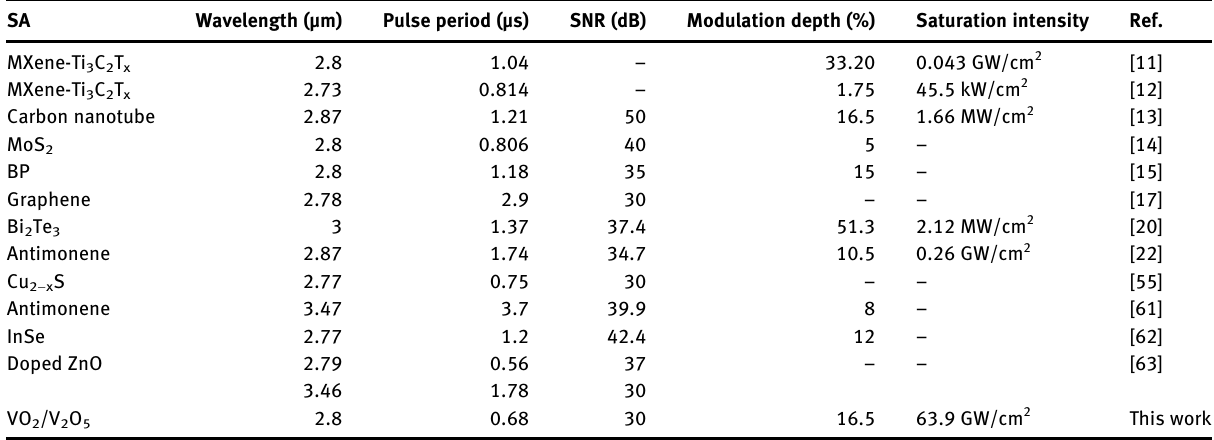
Table  : Laser pulse parameters for Q-switching by different types of SA near  .  µm